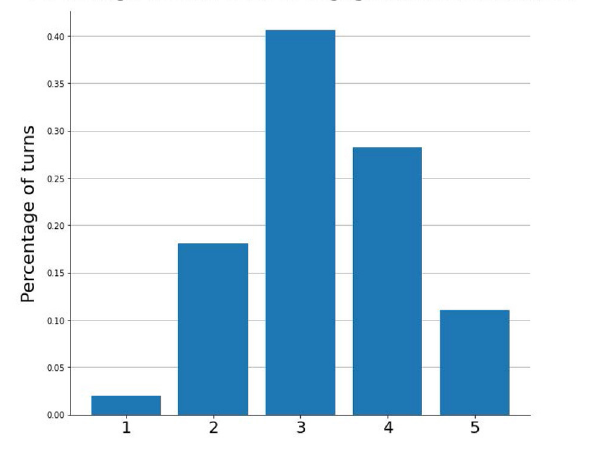
FIGURE2 Distribution of engagement levels in the dataset.